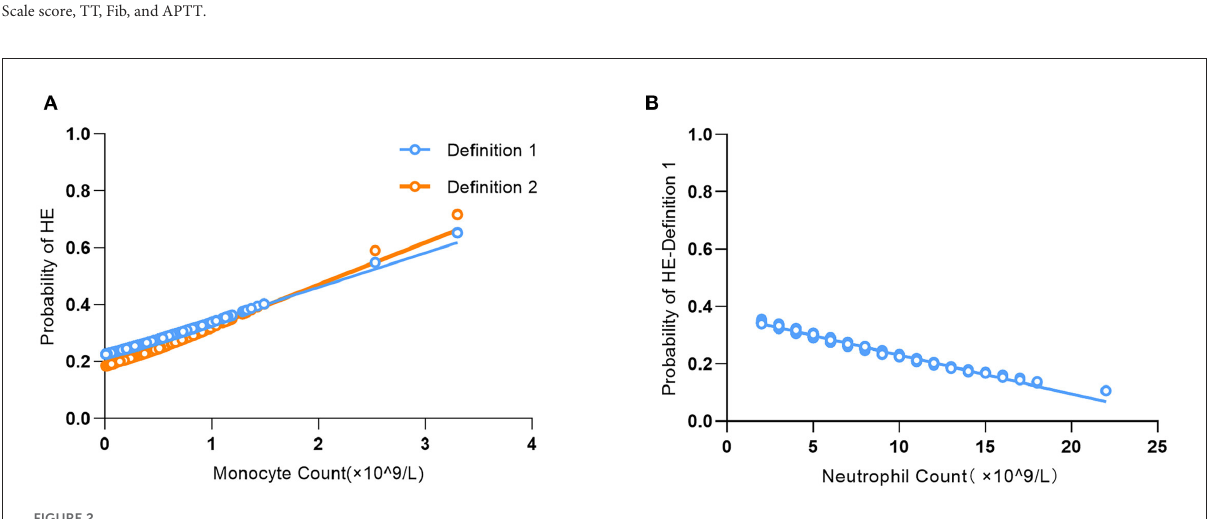
CI: 0.96–1.34, P = 0.1257) and monocyte count (aOR: 1.61,